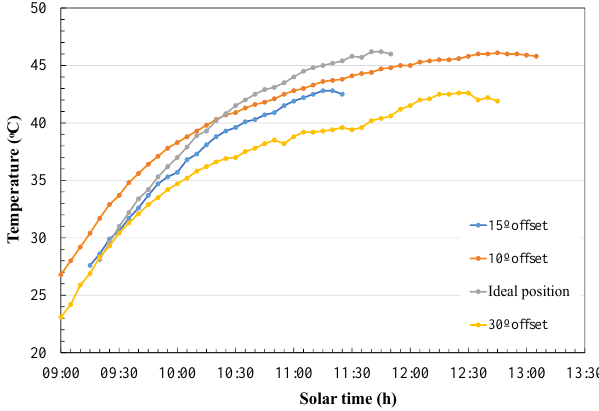
Figure 22. Variation of water temperature at external receiver sur- face over time.